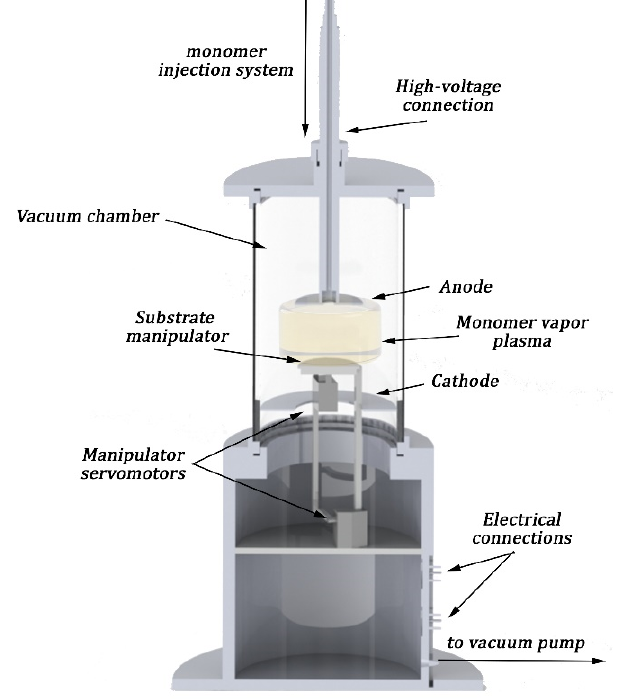
Figure 1. Scheme of the deposition setup.